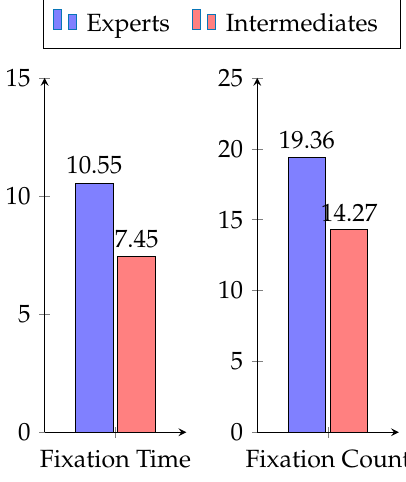
Figure 4. Eye-gaze histograms. Left : Percentage of fixation (in seconds) for all tasks. Right : average over all tasks of the number of